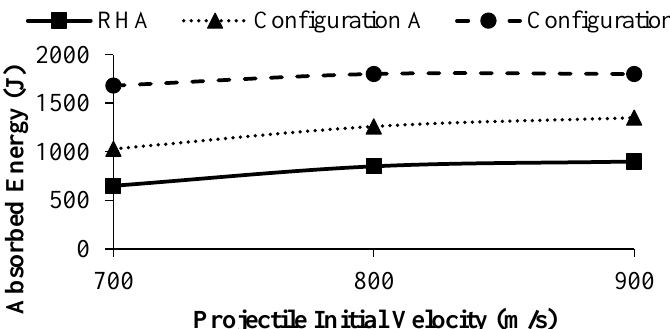
Figure 16. Total energy absorbed by the laminated panel at different initial projectile velocity.